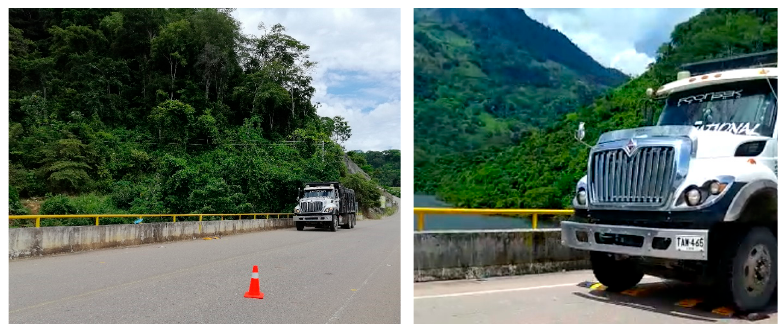
Figure 14. Three-axle 32-ton truck moving at a speed of 40 km/h on the Tablazo bridge.